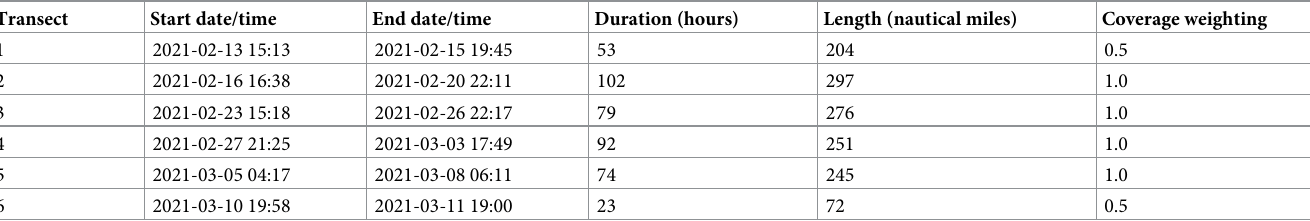
Table 1. Acoustic transect duration (times in UTC), length and coverage weighting of the large scale survey.